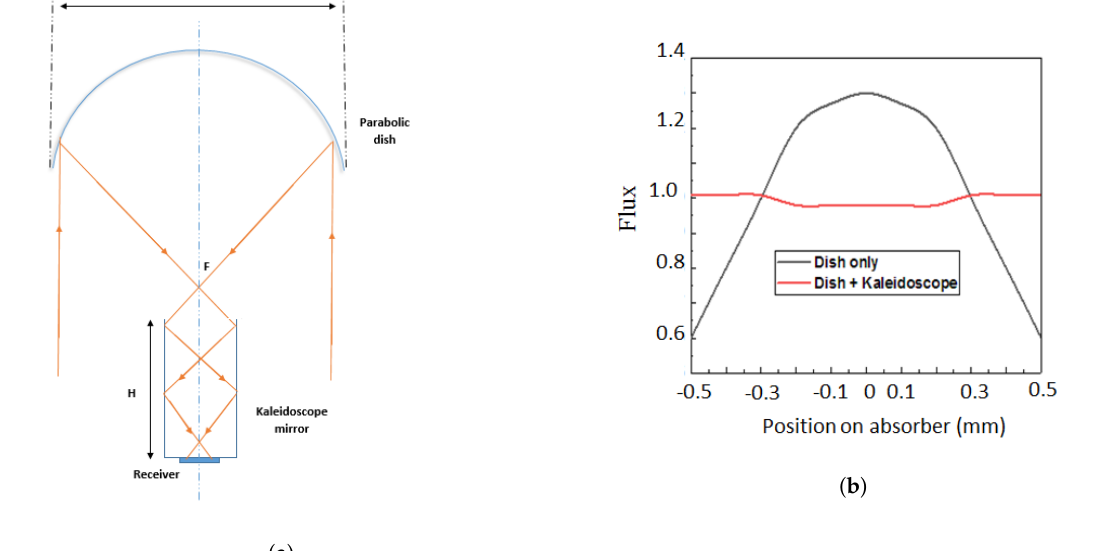
Figure 33. Solar concentrator design based on a parabolic dish as the POE associated with a kaleidoscope mirror proposed by Ries et al. [64]. ( a ) Proposed optical elements; ( b ) flux distribution at the exit of this optical